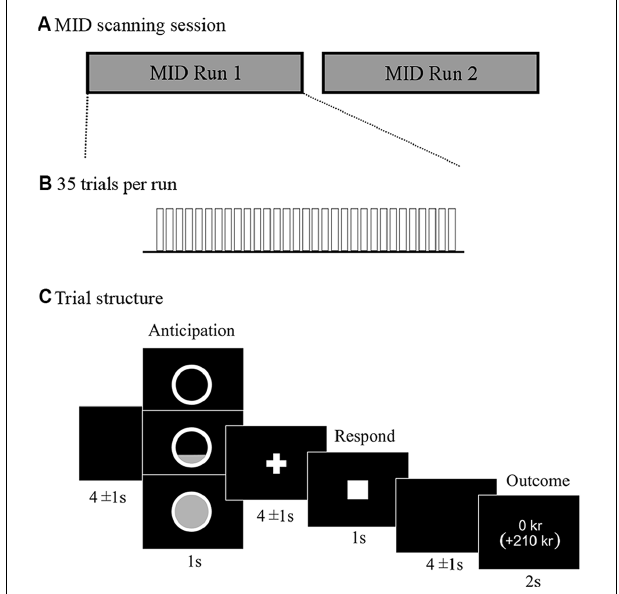
FIGURE 1 | Description of the monetary incentive delay (MID) scanning session (A) and trial structure of the modified version of the MID task ( B,C ). Presentation software (Neurobehavioral Systems) was used to present the task in the scanner. The whole MID task required ≈ 35 min of scanning. Each of the two runs consisted of 35 trials of ≈ 16 s each, which resulted in 9.3 min per run. This led to an approximate scanning time of 10 min per run including instructions at the beginning of each run and repetition of trials due to possible mistakes of the participant. There was a total of 70 trials. The outcome was not dynamically adjusted but fixed to yield the same number of wins for each participant with a success rate of 50% for each reward level. Participants were told that different trials would vary in difficulty, and they were instructed to always respond as fast as they could to win as much as possible, even if some trials would require an impossibly fast response and be highly unlikely to result in a win. Participants were explicitly instructed to only press the button once for each trial. There were 14 Baseline trials where participants anticipated no win, and could not win anything, but were encouraged to press the button nevertheless in the same way as in the reward trials. There were 28 trials with the opportunity to win 10 SEK (subsequently referred to as Low win , equivalent to ≈ 1 Euro), and 28 trials with the opportunity to win 50 SEK (subsequently referred to as High win , equivalent to ≈ 5 Euro). As the actual winning rate was fixed, 50% of the trials resulted in “Failed” win and consequently no reward outcome. The uncertainty of the outcome was important to keep participants motivated to perform. The outcome phase included a presentation of the winning amount in the current trial, as well as the total accumulated sum below in